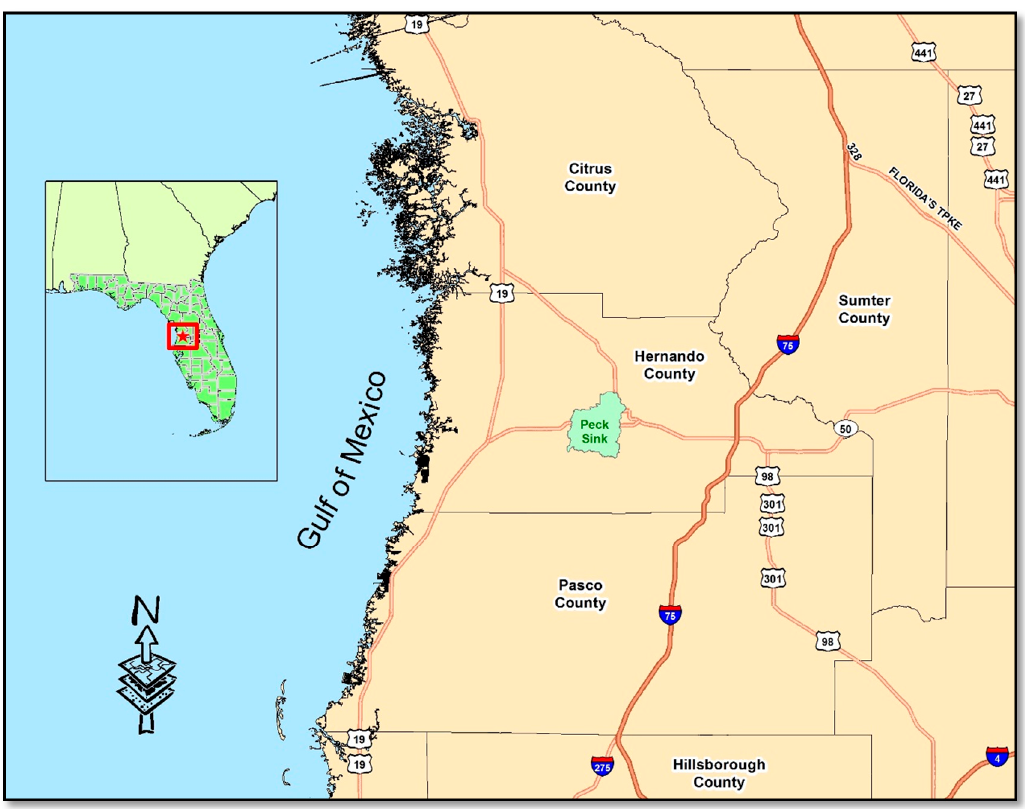
Figure 1. Location of the Peck Sink Watershed in Hernando County, Florida.